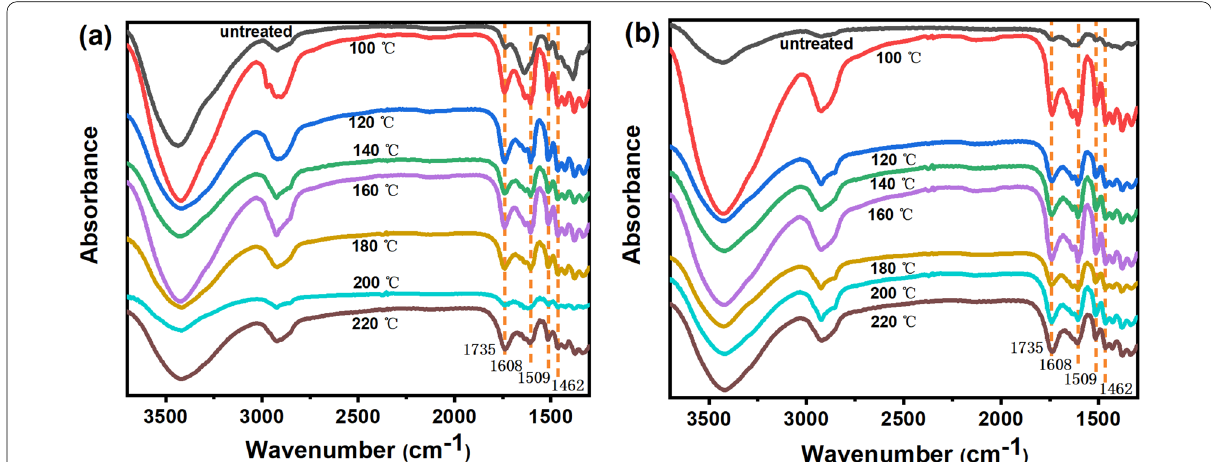
Fig. 6 FTIR spectra of a fibers and b parenchyma cells with heat treatments